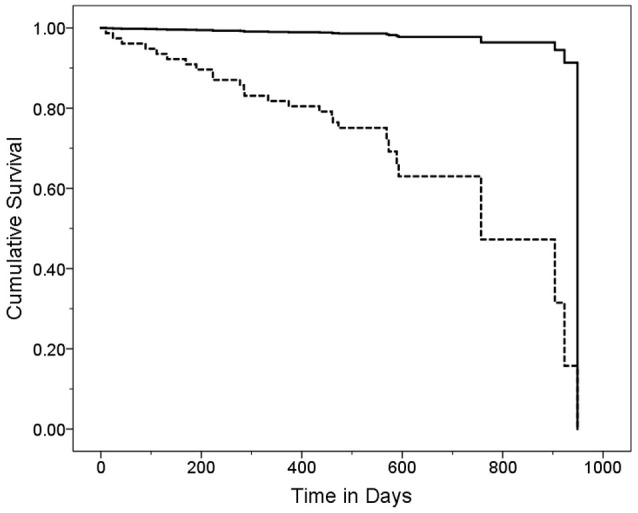
Survival Curve by Age Category. ET cases were stratified into two age groups based on the median age (80 years). Older ET cases (solid line) had a mean ± standard deviation [median] age = 87.9 ± 4.3 [88.0] years and younger ET cases (dashed line) had a mean ± standard deviation [median] age = 73.6 ± 5.9 [75.0] years. Hazards ratio (95% Confidence Interval) in Cox proportional-hazards model = 20.43 (2.75–151.95), p = 0.003.